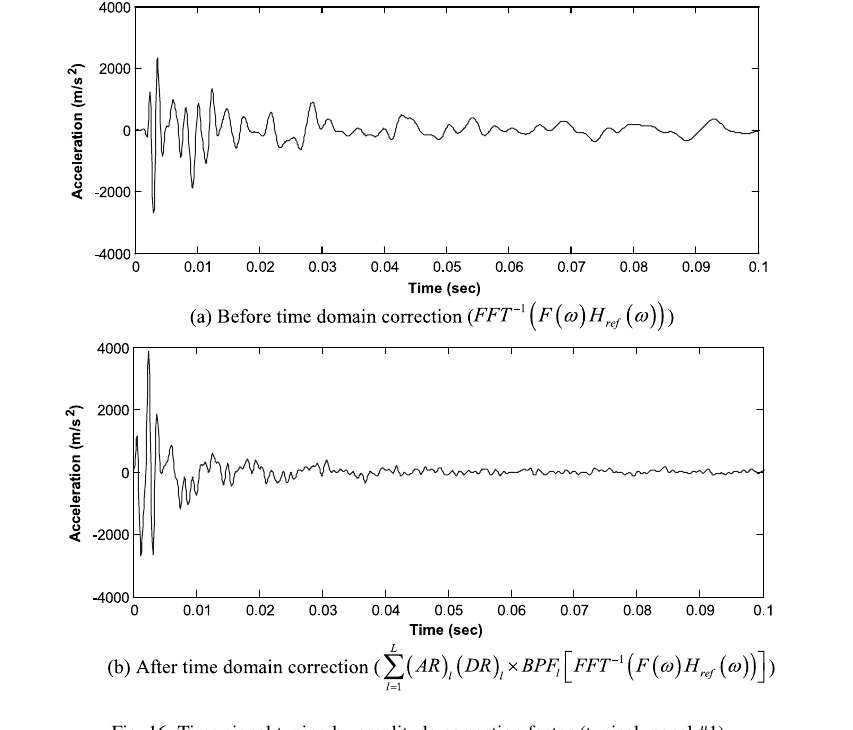
Fig. 16. Time signal tuning by amplitude correction factor (typical, panel #1).